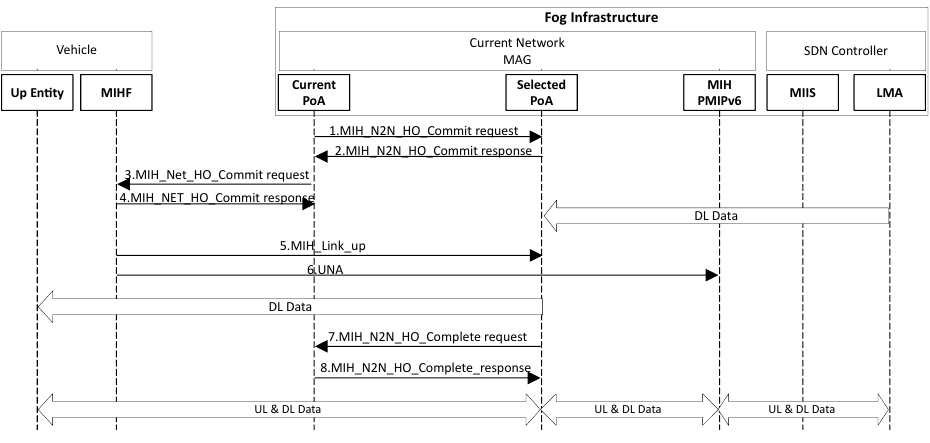
Figure 10. The intra-MAG predictive VHO